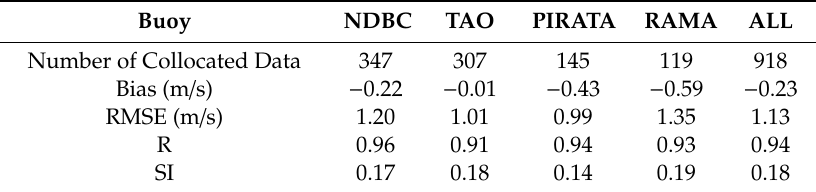
Table 2. WS errors between Sentinel-3B and moored buoys.